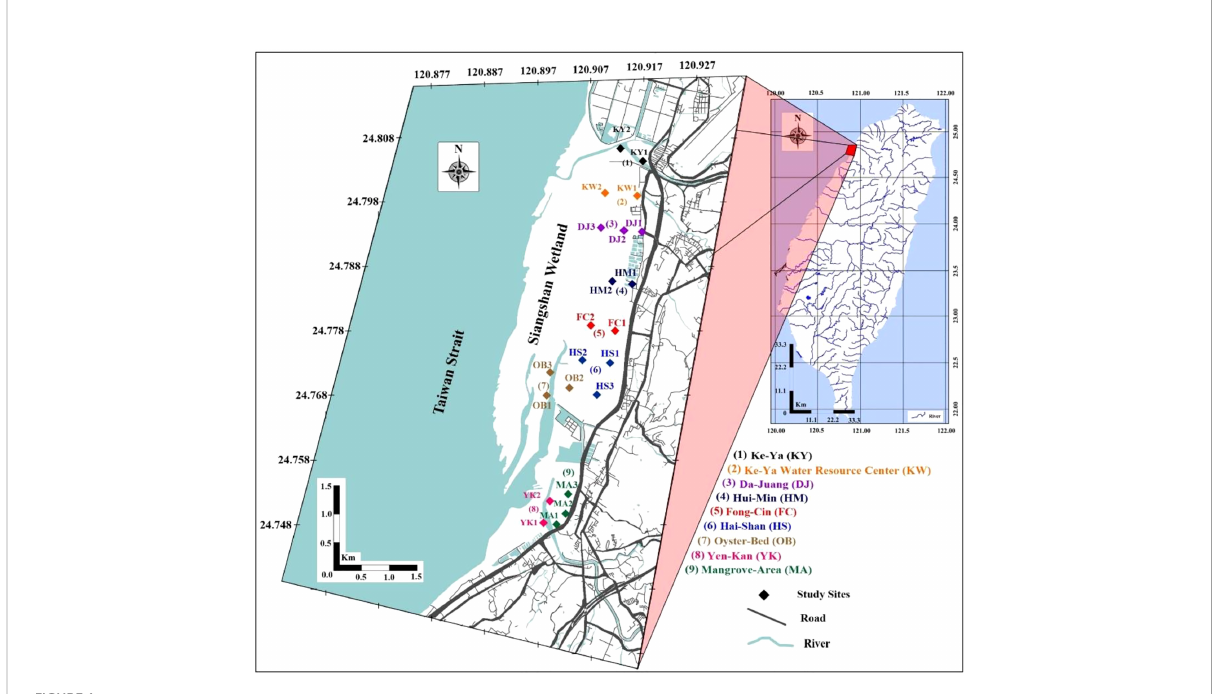
FIGURE 1 Map of the areas of the 22 sampling sites at the Siangshan wetland, Hsinchu,